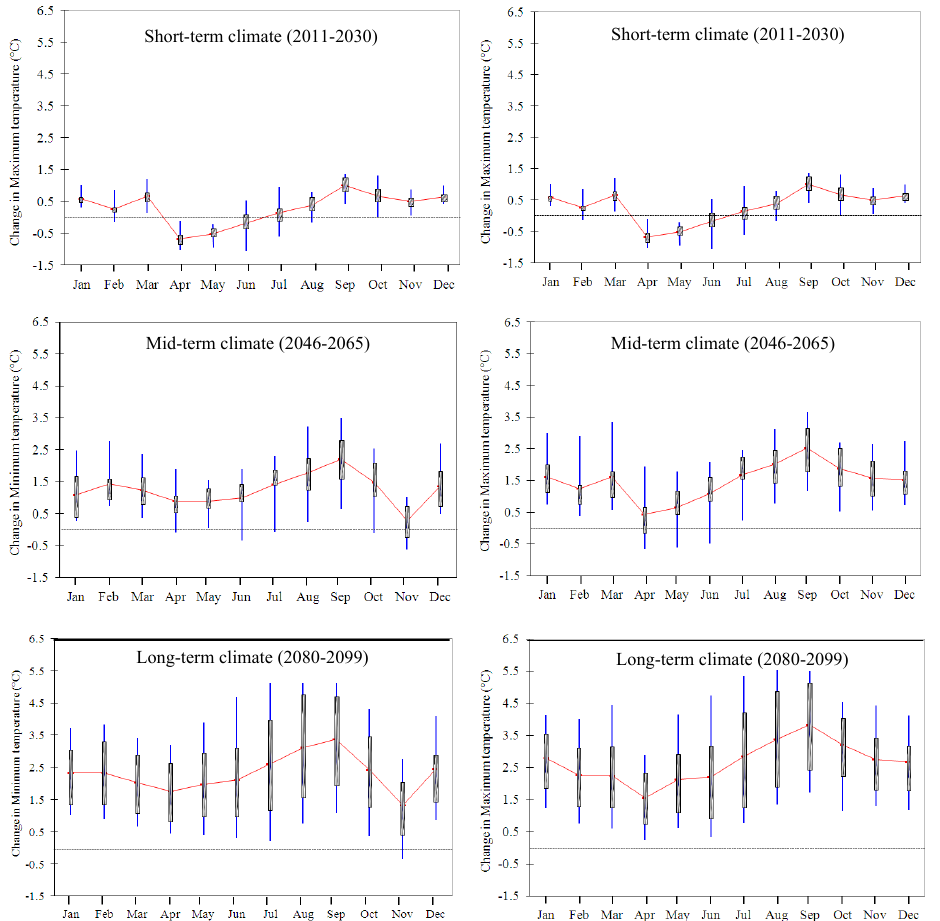
Fig. 6 The change in monthly average minimum and maximum temperatures compared to temperatures of the baseline time period. The box-plots represent the interquartile range for the 25th and 75th percentiles from all 10 scenarios. The solid line represents the average of 10 scenarios.